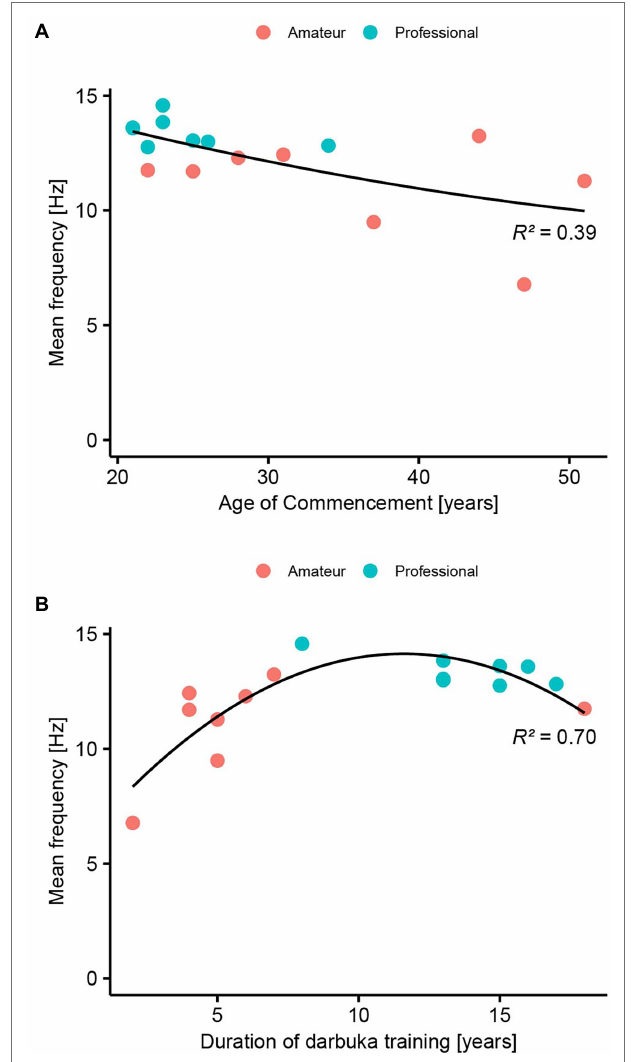
FIGURE 7 | (A) Correlation between age at the commencement of darbuka training and tapping frequency in double-finger tapping task. A polynomial fitting curve and the R-squared value are shown. (B) Correlation between duration of darbuka training and tapping frequency in double-finger tapping task. A polynomial fitting curve and the R -squared value are